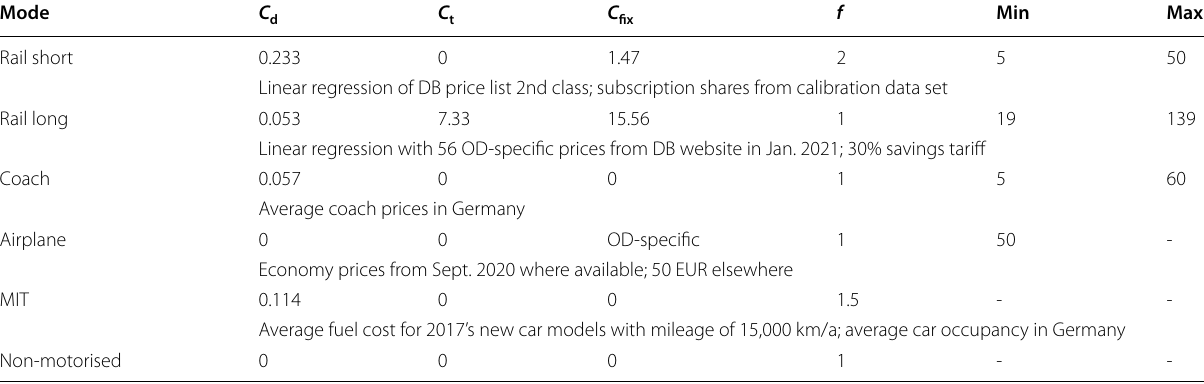
Table 2 Monetary cost function components by mode of transport in 2017 Mode C d C